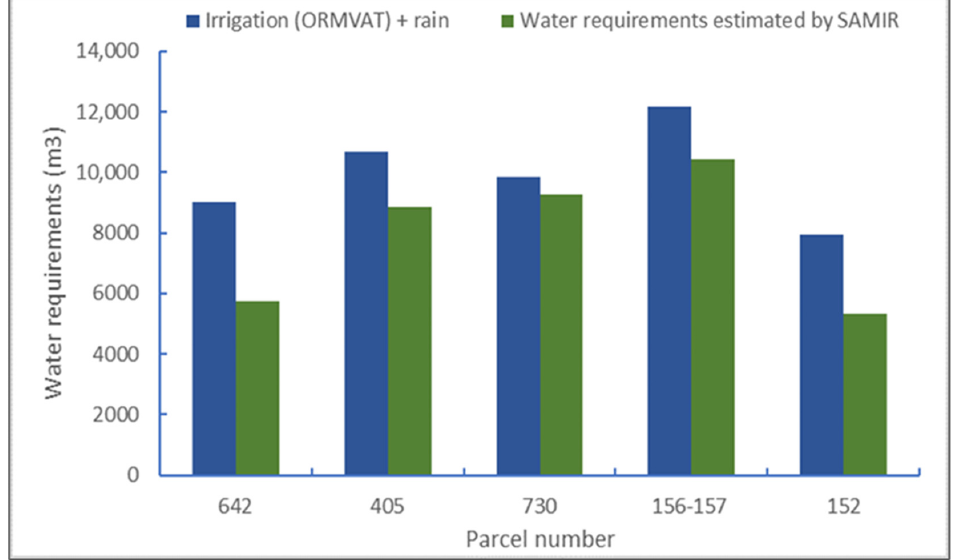
Figure 11. Comparison between water requirements and irrigation water supplies